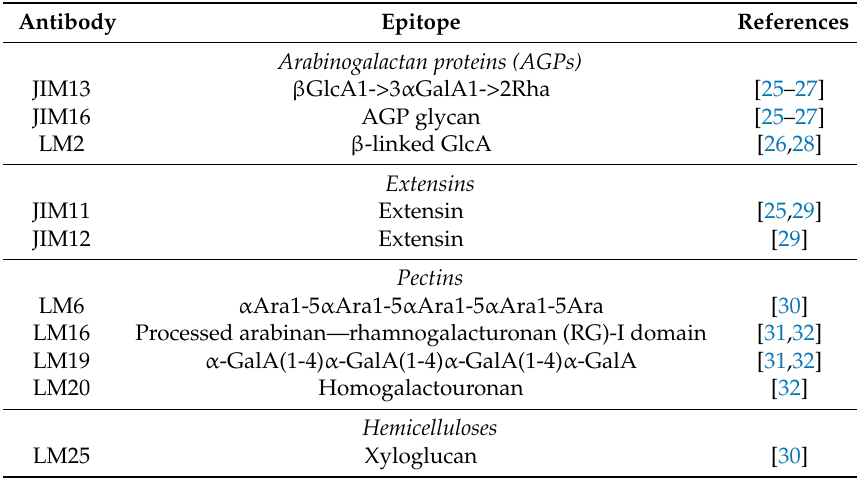
Table 1. Antibodies used for immunocytochemistry, cognate epitopes, and references. Antibody